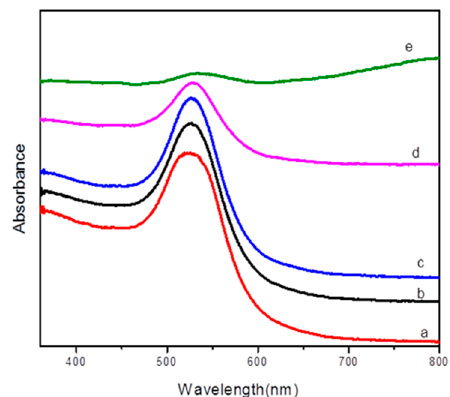
Figure 1. SEM images of different AuNPs ( A ): unconcentrated colloidal AuNPs; ( B ): 2× concentrated colloidal AuNPs; ( C ): NaCl-modified AuNPs; ( D ): NaCl-modified AuNPs with flumetsulam under the addition of MgSO 4 ).